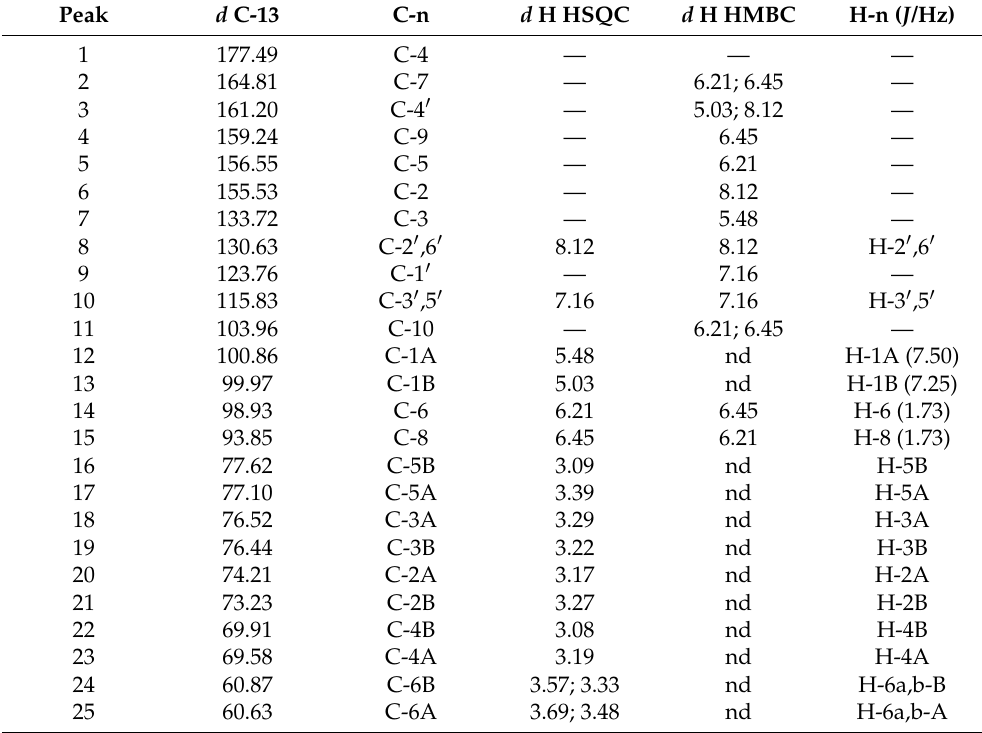
Table 2. NMR data of kaempferol-3,4 ′ -di -O- β - glucoside (400 MHz, DMSO- d 6, 300 K).